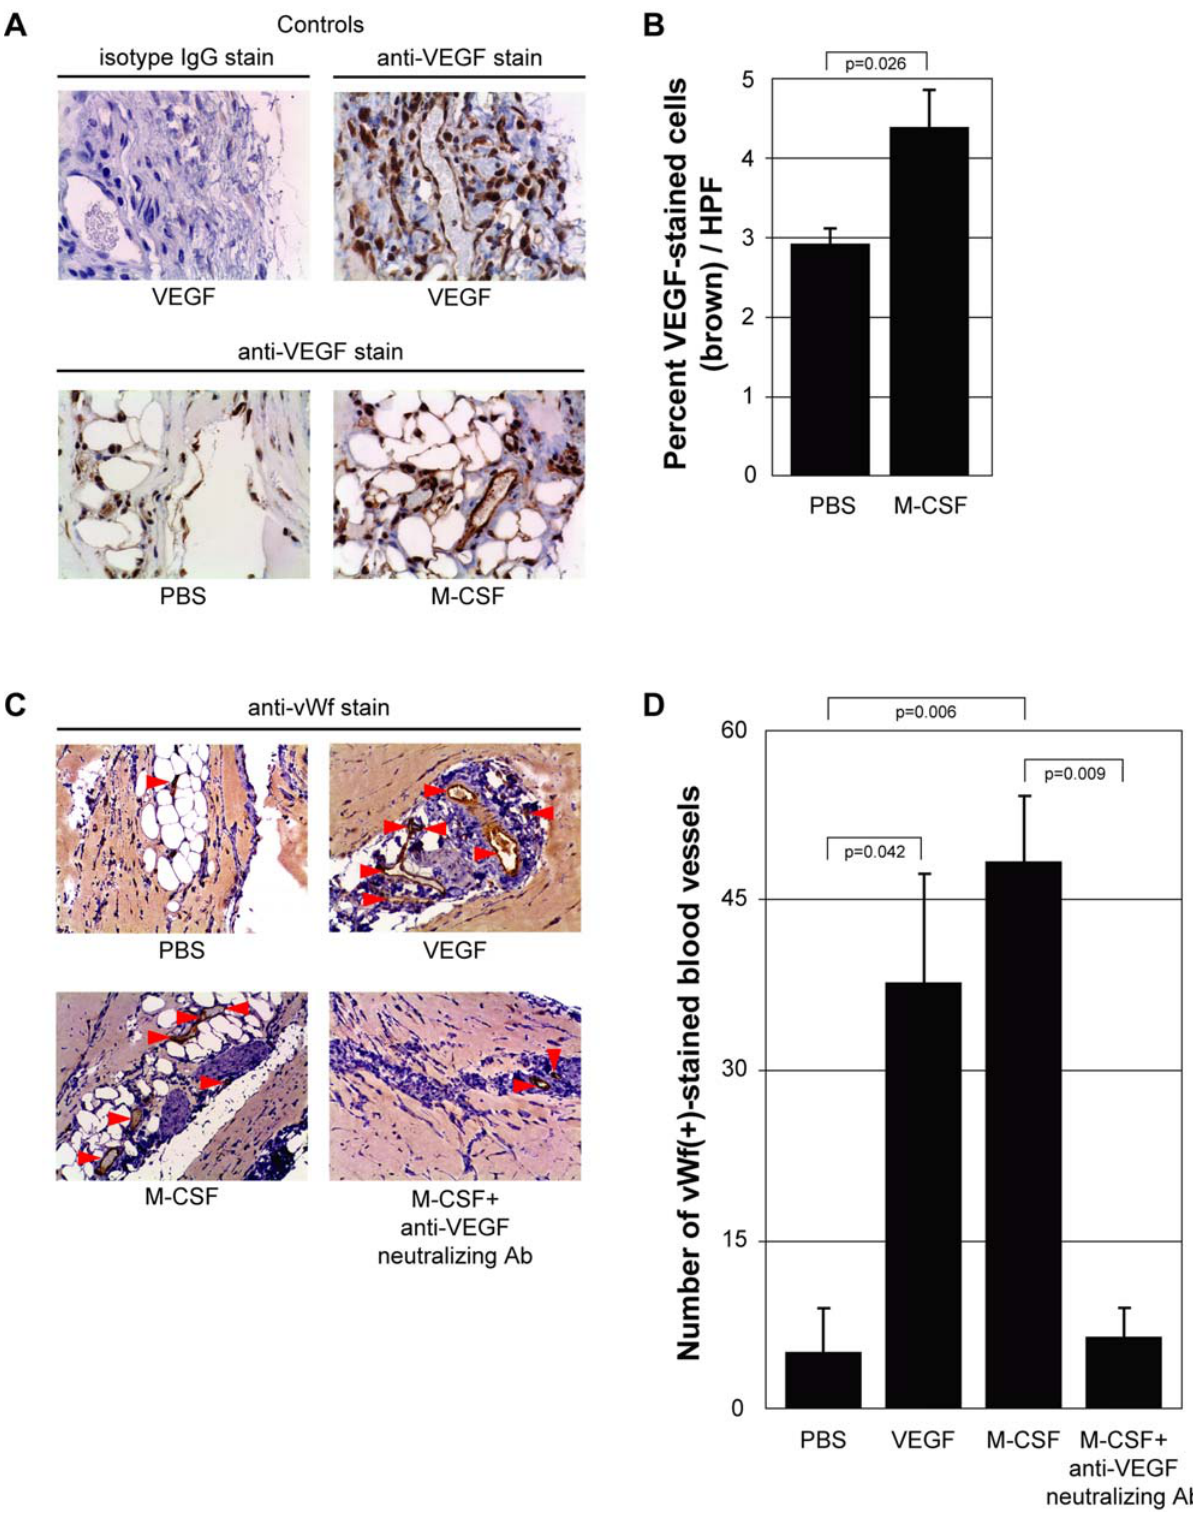
Figure 7. M-CSF induces VEGF and regulates angiogenesis invivo . A) Matrigel TM was resuspended with PBS (PBS) , rmVEGF (10 ng/ml) (VEGF) or rmM-CSF (100 ng/ml) (M-CSF) . The slides were stained with either an anti-mouse VEGF antibody or its isotype IgG. Brown staining represents VEGF within the plug. Pictures were taken using a 20 6 objective lens. B) The amount of brown stain (VEGF) within the plugs was determined by taking 15 digital images randomly using a 20 6 objective lens in a blinded manner. Quantification of VEGF within each plug was determined by Adobe Photoshop histogram pixel analysis of the brown stain. C) Matrigel TM was resuspended with PBS (PBS) , rmVEGF (10 ng/ml) (VEGF) , rmM-CSF (100 ng/ ml) (M-CSF) , or rmM-CSF (100 ng/ml) + anti-VEGF neutralizing antibody (5 m g/ml) (M-CSF + anti-VEGF neutralizing Ab) . The plugs were stained for